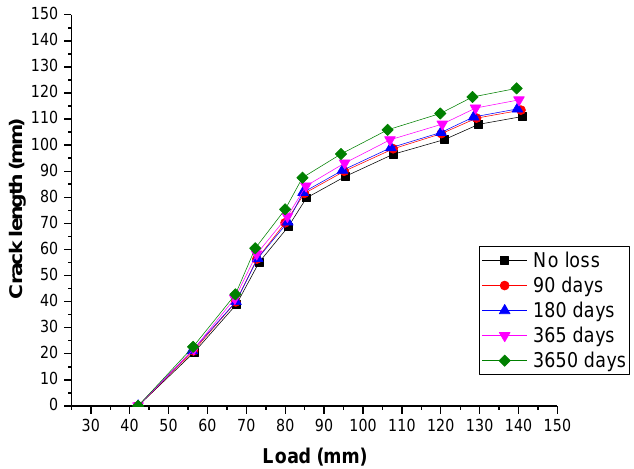
Figure 7. Effect of creep in terms of load-crack length response.